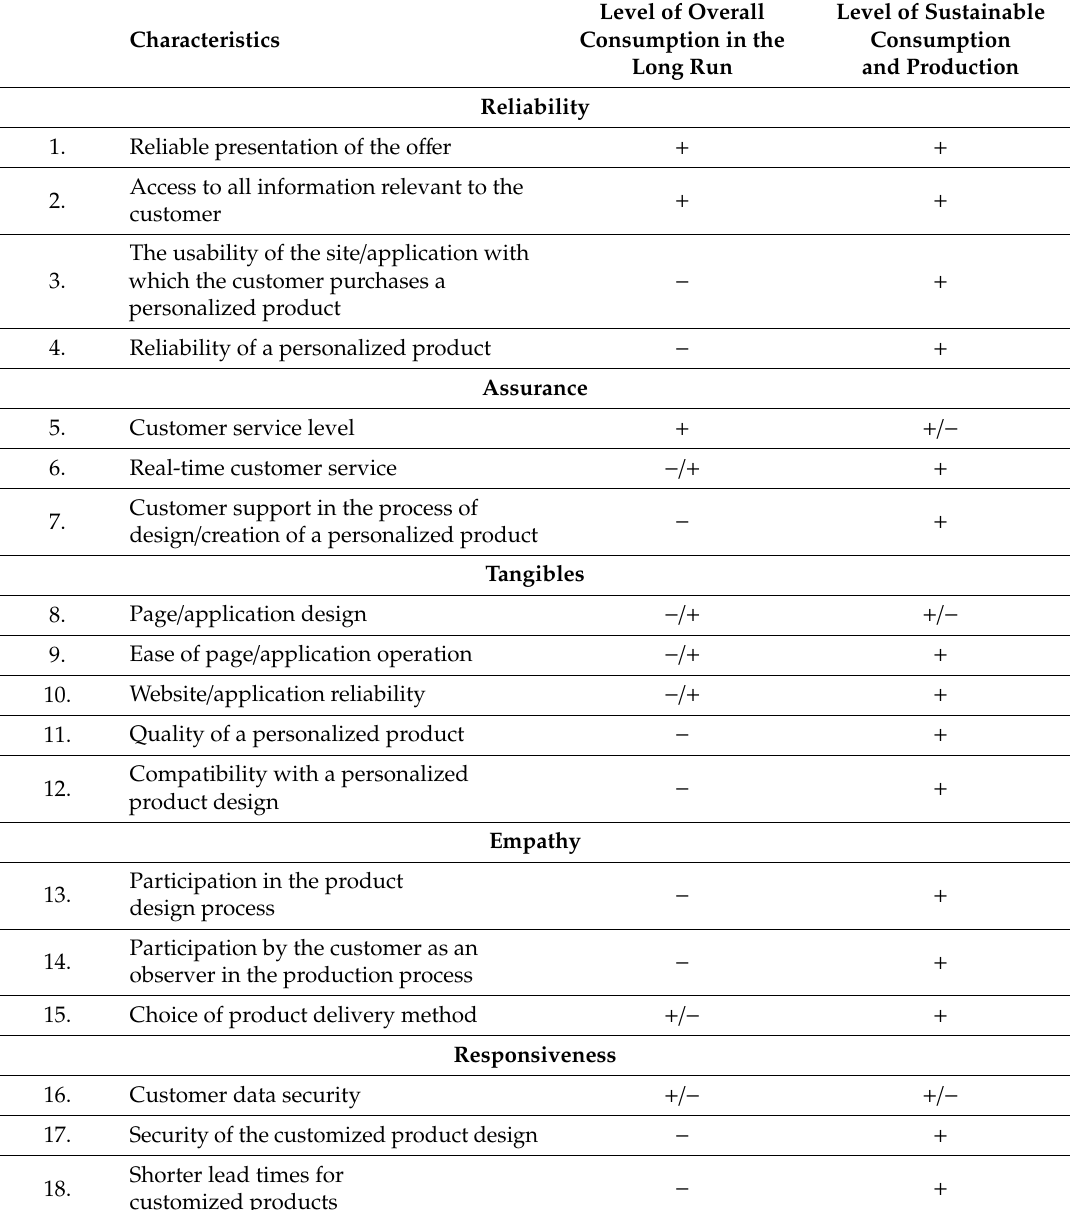
Table 5. Impact of the characteristics on changes in overall and sustainable consumption.